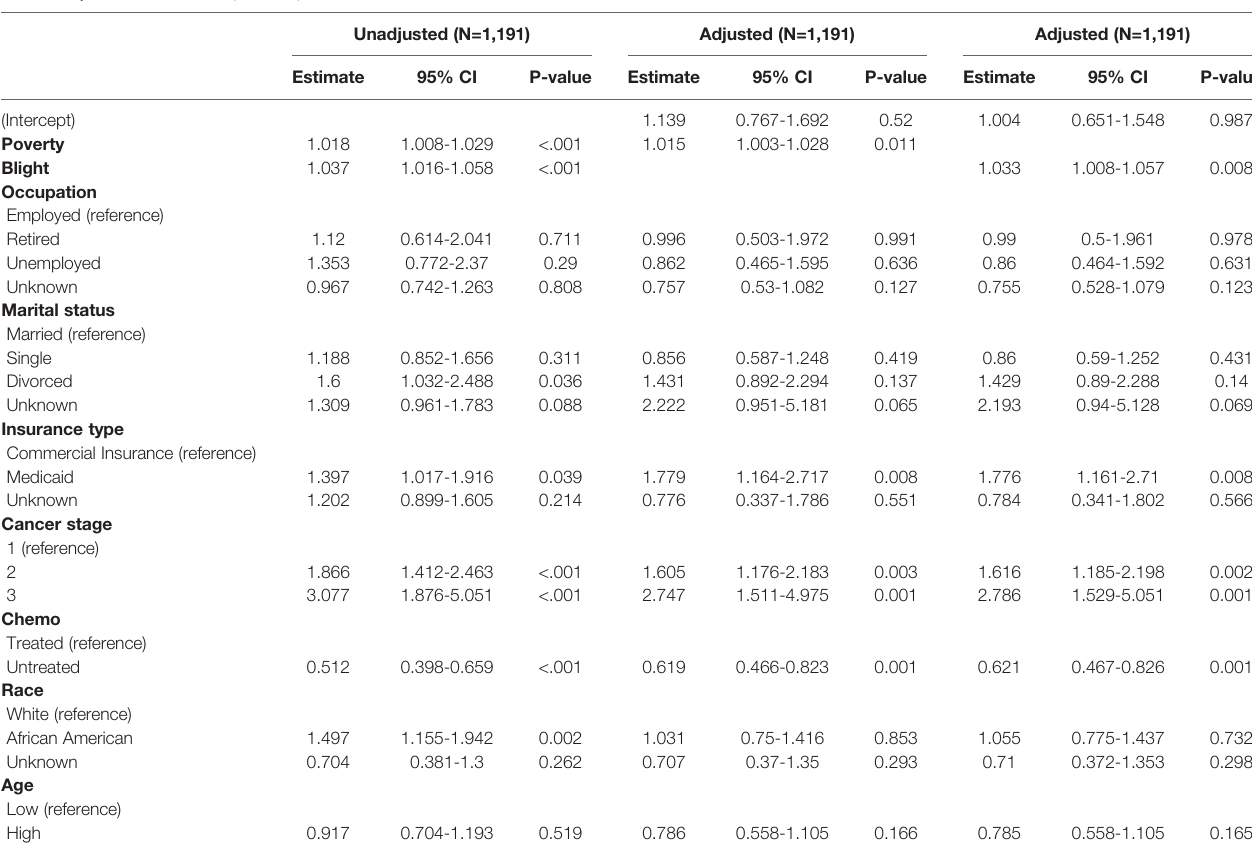
TABLE 2 | In fl ation model: no pain vs.